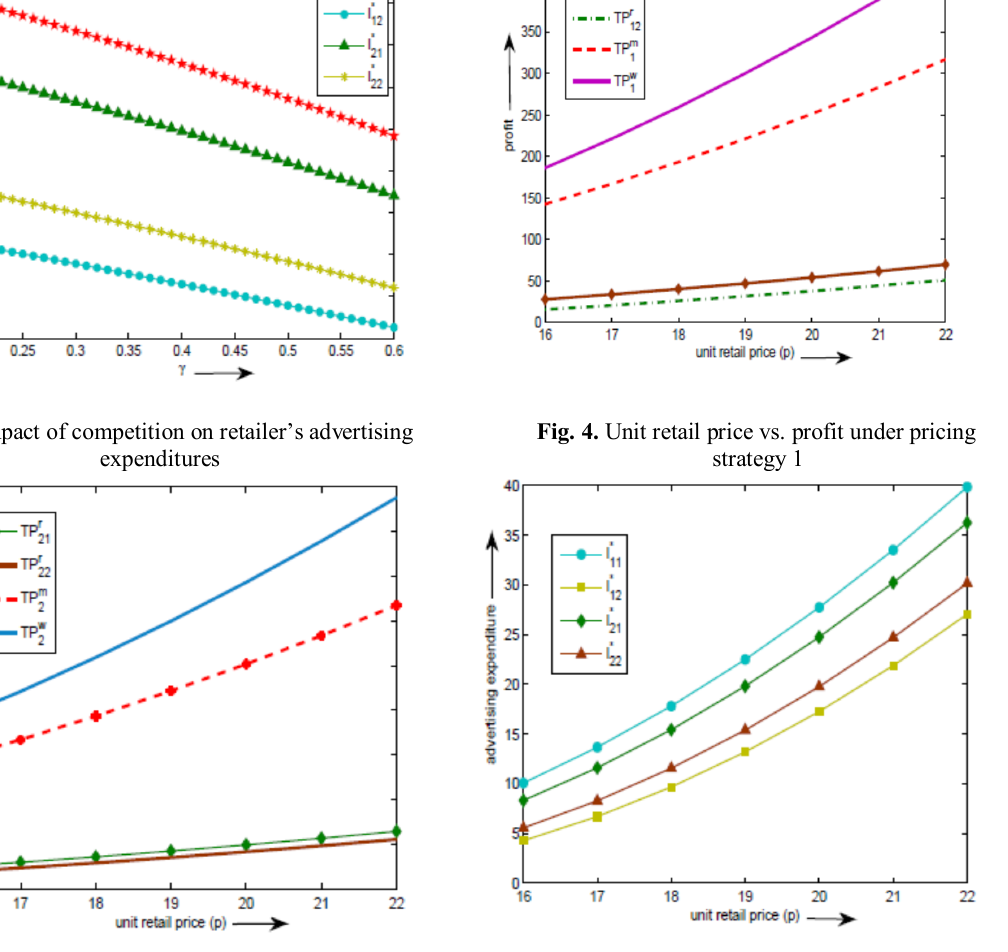
Fig. 5 . Unit retail price vs. profit under pricing Fig. 6. Unit retail price vs. retailers’